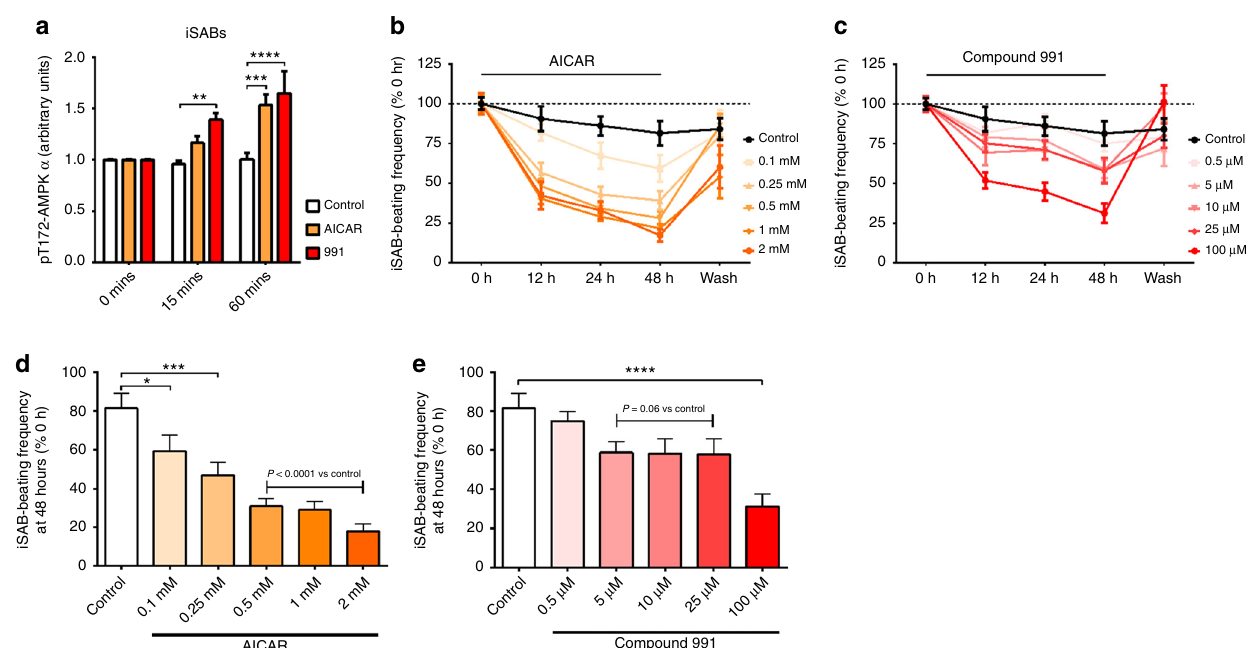
Fig. 5 Pharmacological activation of AMPK reduces the spontaneous beating rate of iSABs. a ELISA analysis of α AMPK Thr172 phosphorylation in iSABs treated with the AMPK activator AICAR- or the small-molecule AMPK activator compound 991 ( n = 4). b Effect of incubation with variable doses of AICAR or control on iSAB-beating rate. c Effect of incubation with variable doses of compound 991 or control on iSAB-beating rate. d Bar chart representation of AICAR dose – response effect data shown in b speci fi cally for the 48 h incubation time point. e Bar chart representation of compound 991 dose – response effect data shown in c speci fi cally for the 48 h incubation time point. a Two-way ANOVA was performed. d , e One-way ANOVA followed by Holm – Sidak ’ s multiple comparisons test was performed. * P < 0.05, ** P < 0.01,*** P < 0.001, **** P < 0.0001. a – e Data are shown as means ±